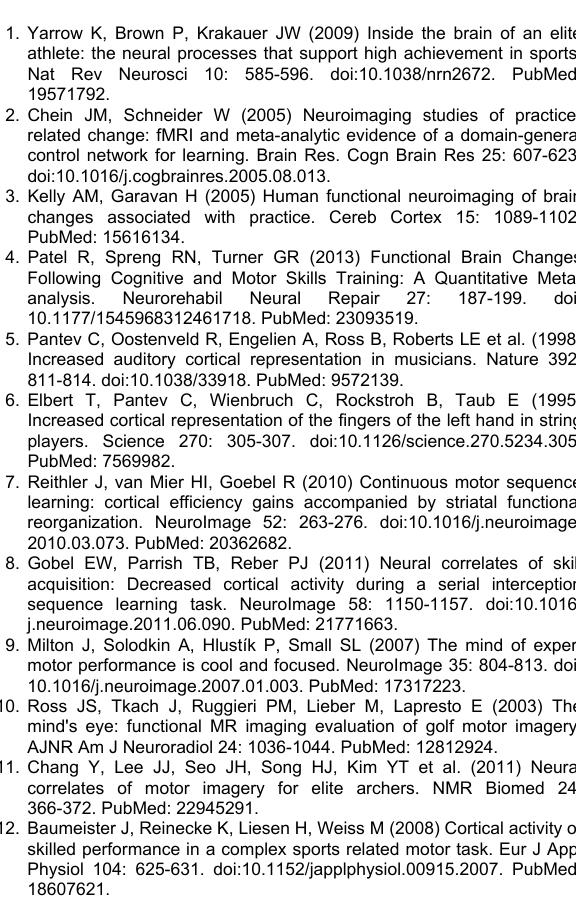
Table S2. Talairach coordinates for the centers of mass of regions of interest (ROIs) included in the multivariate autoregressive (MAR) analyses for the motor reaction task and the visuo-spatial task.